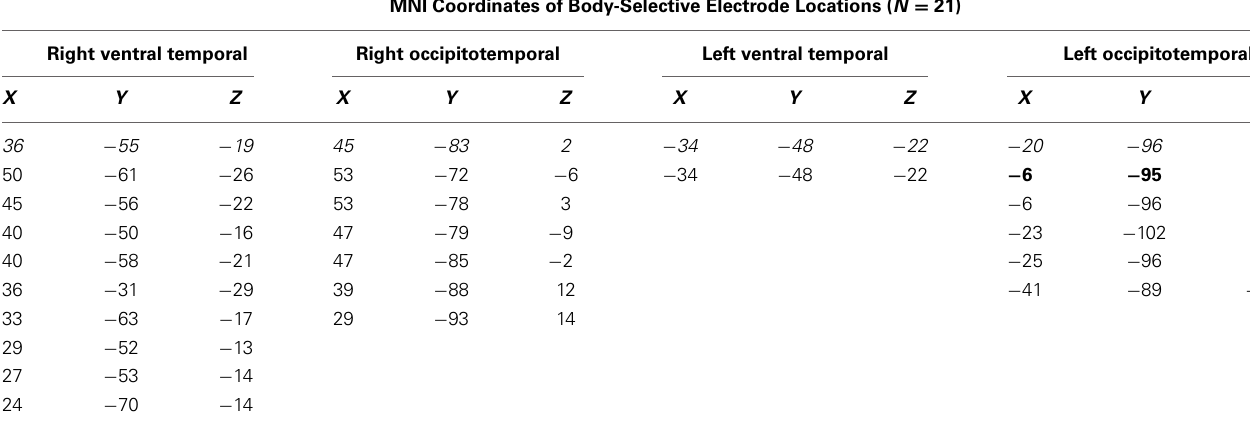
Table 3 | Electrode locations of body-selective sites within each spatial cluster. MNI Coordinates of Body-Selective Electrode Locations ( N = 21) Right ventral temporal Right occipitotemporal Left ventral